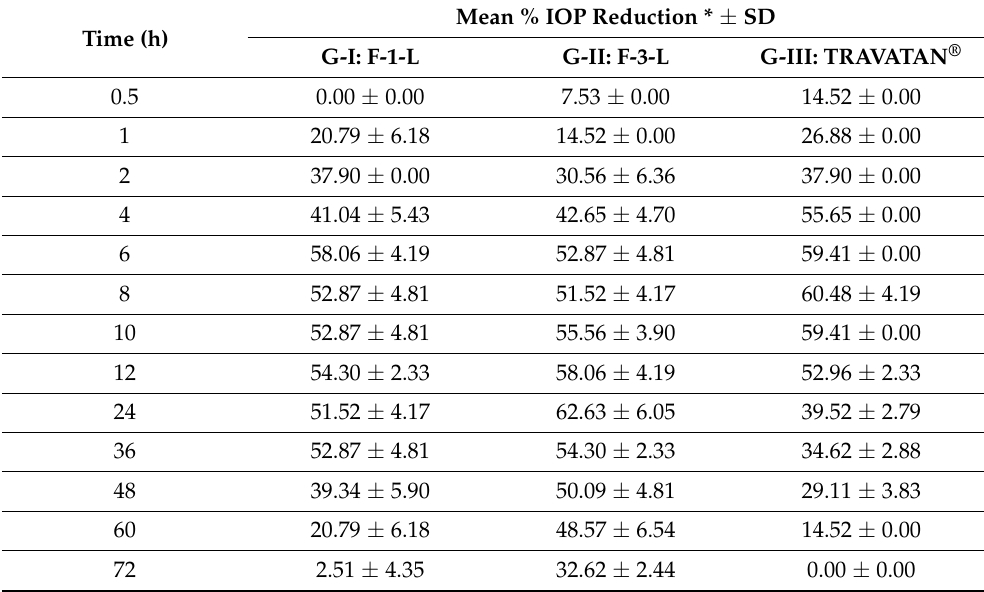
Table 6. The percent reduction in intraocular pressure in the left rabbit’s eye was treated with the different prepared formulae F-1-L, F-3-L, and Travatan ® over 72